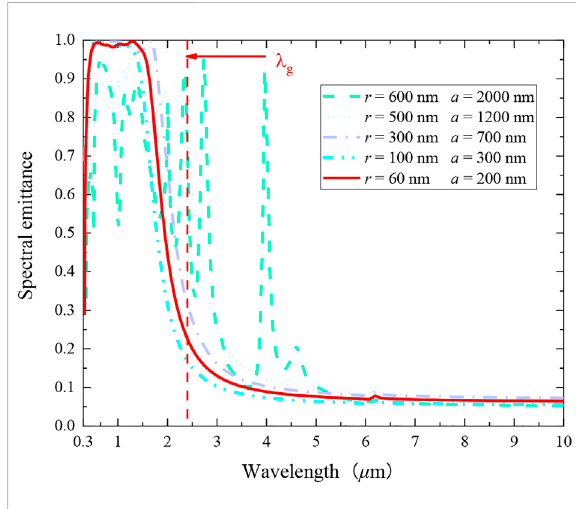
FIGURE 2 When other parameters are fi xed ( LP = 10, d M = 10 nm, d D = 80 nm, h = 900 nm (90*10), n c = 1), the comparison of spectral emittance for radius and period changes ( r = 600 nm, a = 2000 nm, r =500 nm, a =1,200 nm, r =300 nm, a =700 nm, r = 100 nm, a = 300 nm and r = 60 nm, a = 200